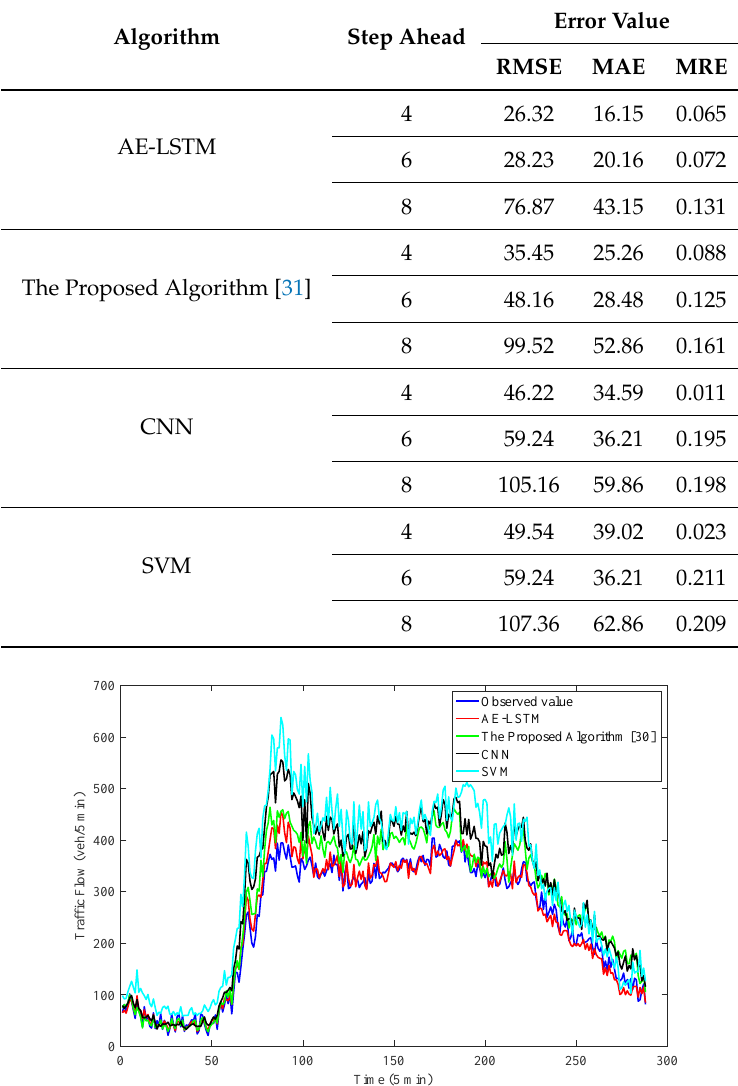
Figure 5. The blue line is the observation value on Sacramento County, the red line is the traffic flow prediction data obtained by AE-LSTM algorithm, and the green line represents the traffic flow prediction data obtained by the algorithm proposed in [17]. The black and light blue lines represent CNN and SVM,